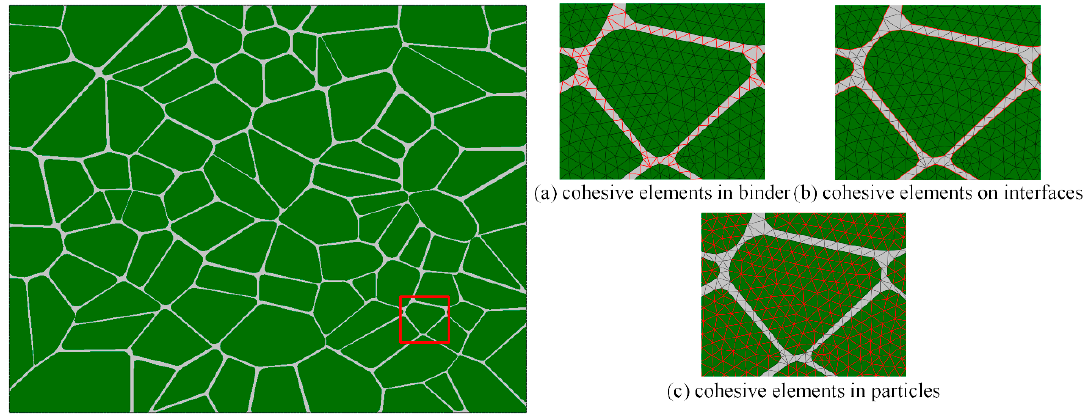
Figure 9. Cohesive elements in the finite element model.